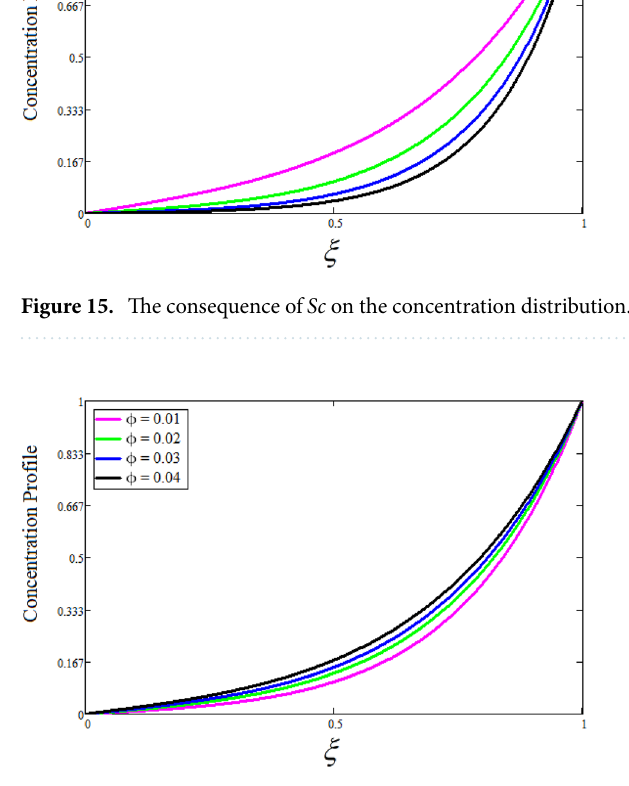
Figure 16. The consequence of φ on concentration distribution. Where α = 0.5, t = 1, Sc = 15.